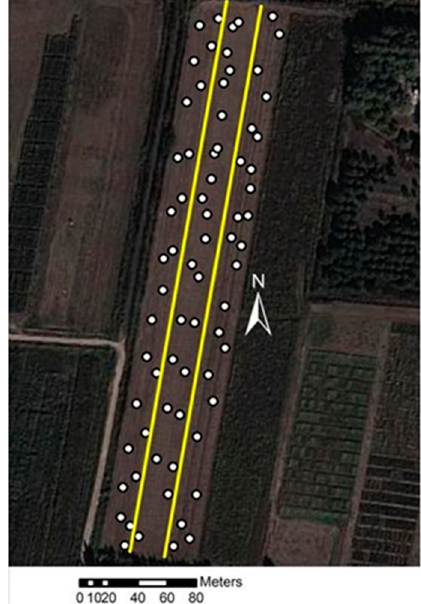
Figure 7. The experimental field.